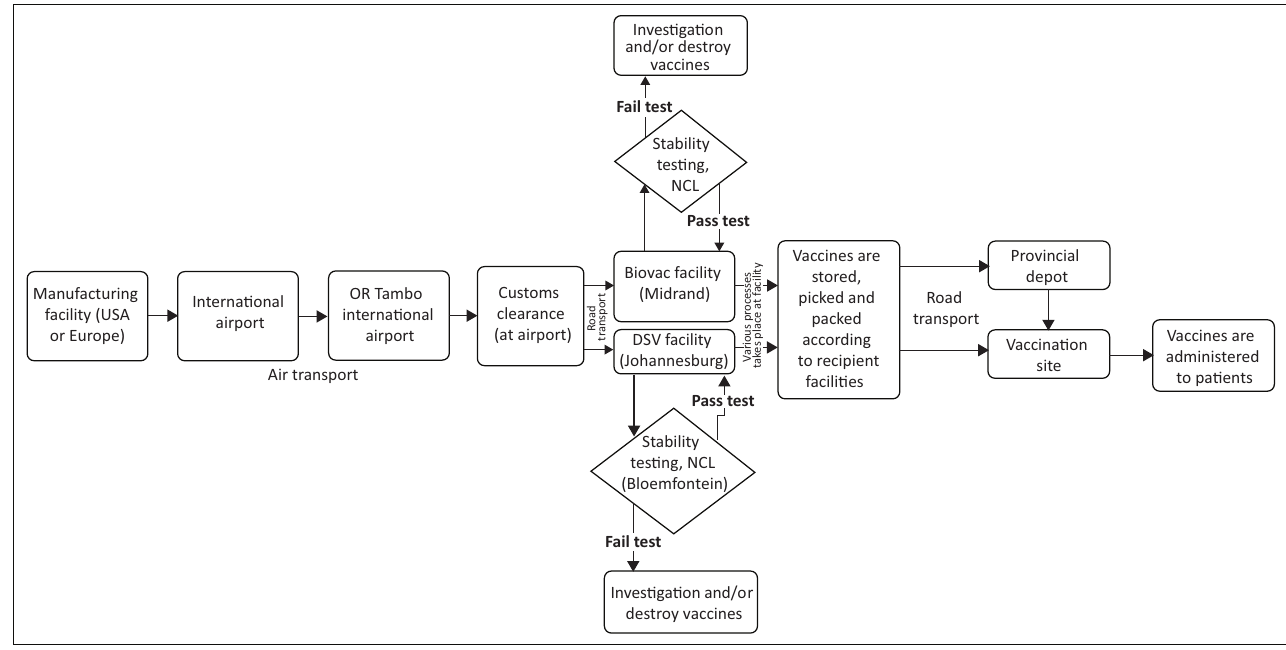
FIGURE 1: COVID-19 vaccine supply chain – South